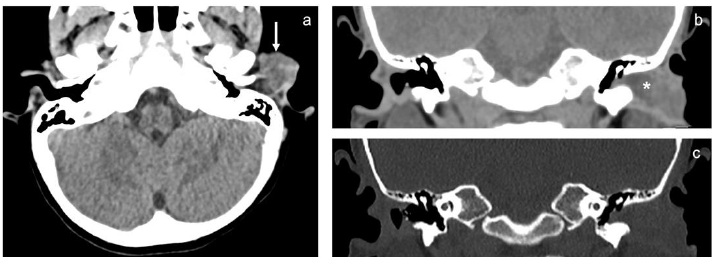
Figure 2. ( a ) CT axial view. White arrow shows the mass that extends outside the left EAC. ( b ) and ( c ) CT coronal view. * shows the mass.